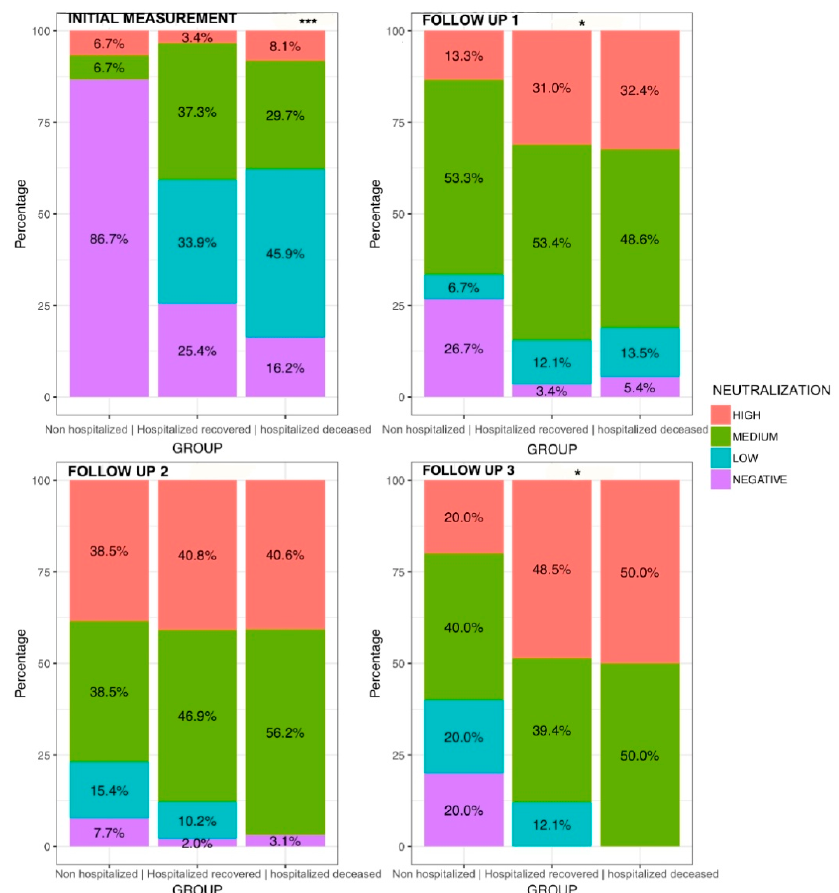
Figure 3. Proportion of patients in each neutralization category. Barplots show the proportion of patients with the different antibody classifications in each follow-up and within study groups (non-hospitalized, recovered, and deceased). Neutralization categories: 0–30% negative production, 31–60% low production, 61–90% medium production, and >90% high production. Initial measurement stands for the first follow-up measurement in a period of <14 days post-symptom onset, follow-up 1 for the period between 14 and 21 days post-symptom onset, follow-up 2 for the period between 22 and 30 days post-symptom onset, and follow-up 3 for the last measurement 30 days post-symptom onset. * = p < 0.05, *** = p <